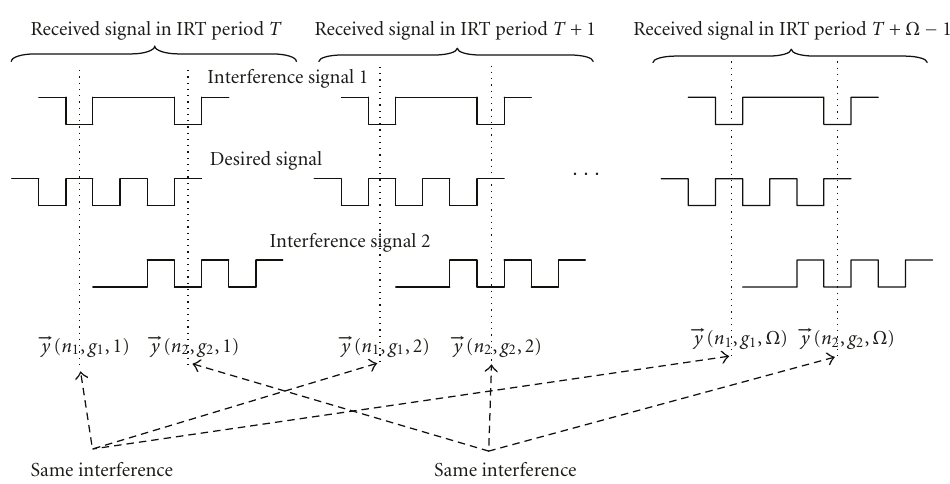
Figure 6: Same chips in di ff erent IRT periods have the same